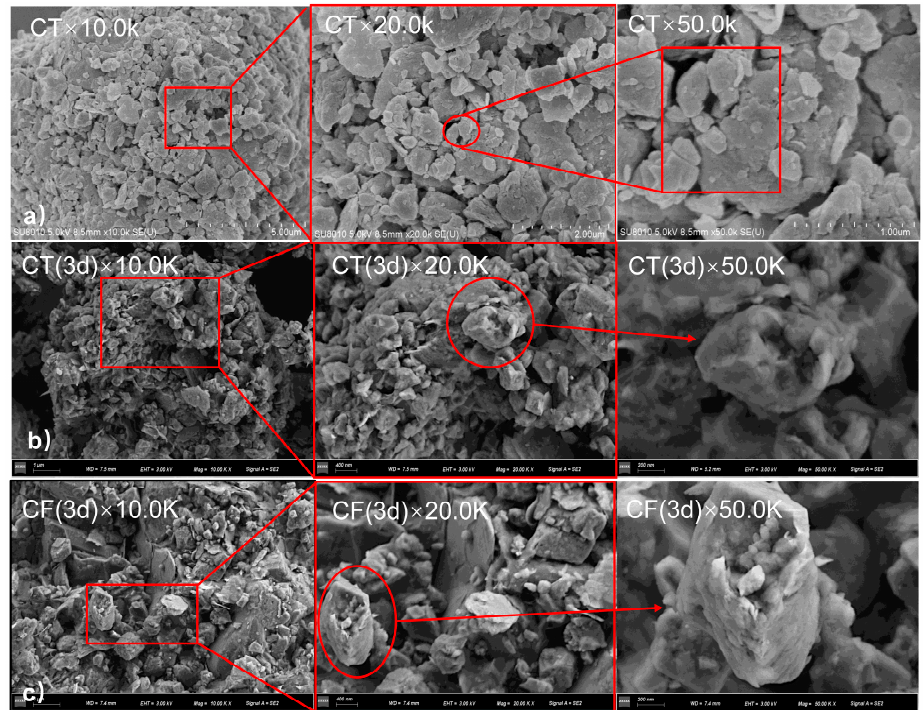
Figure 4. ( a ): SEM images of CT before sorption; ( b ): SEM images of CT with a sorption time of 3 d; ( c ): SEM images of CF with a sorption time of 3 d.